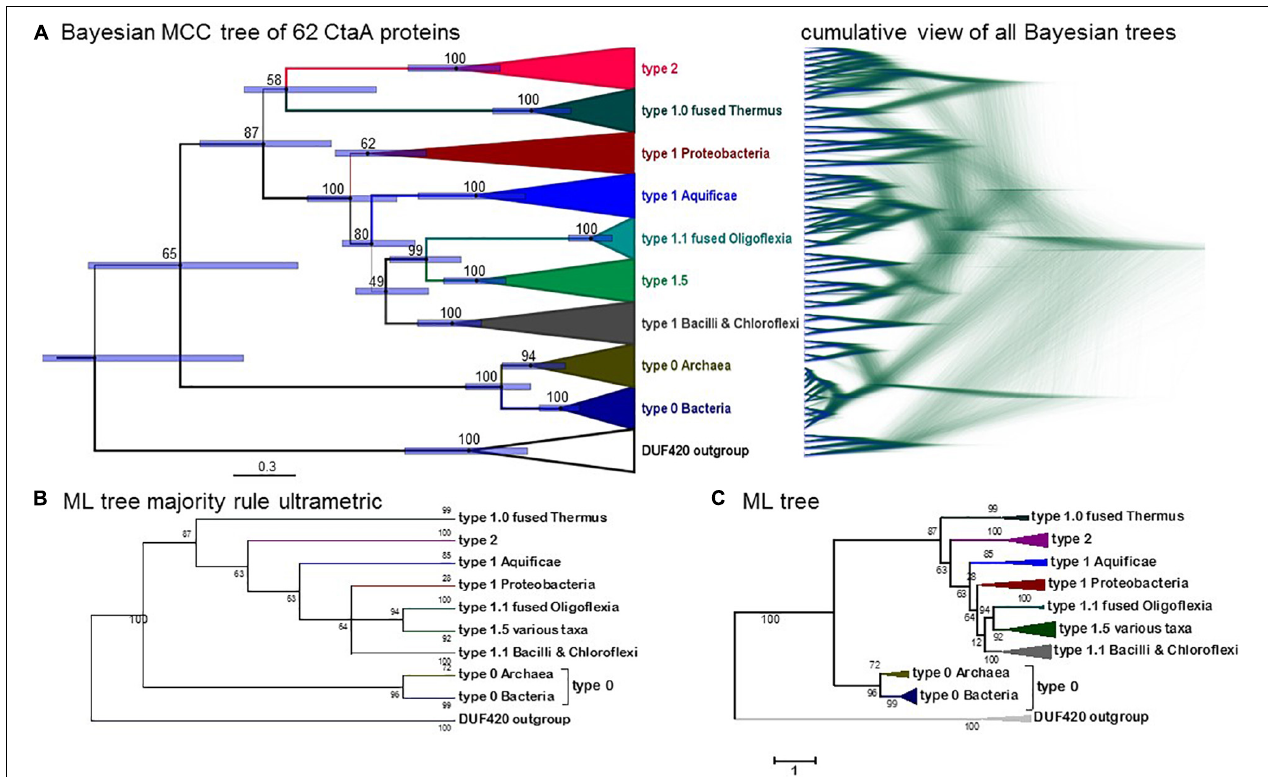
FIGURE 4 | Phylogeny of CtaA proteins from bacterial and archaeal taxa. (A) Bayesian MCC tree obtained from an alignment of 58 CtaA and 4 DUF420 sequences as in Figure 3A (for a total of 358 amino acid sites), with a chain length of 6.2 million iterations; left, BEAST MCC tree with posterior support in% and node bars expressing the 95%_HPD posterior probability, equivalent to confidence intervals (Lee et al., 2013); right, overlaid 5581 trees in mirror image with the DensiTree program. (B) Majority rule-like ML tree obtained with the same CtaA alignment as in Panel (A) using the MEGA5 program (1000 bootstraps) by collapsing clades with less than 50% support. (C) ML tree obtained with MEGA5 as in Panel (B) without further manipulation. Similar ML trees were obtained with other programs such as